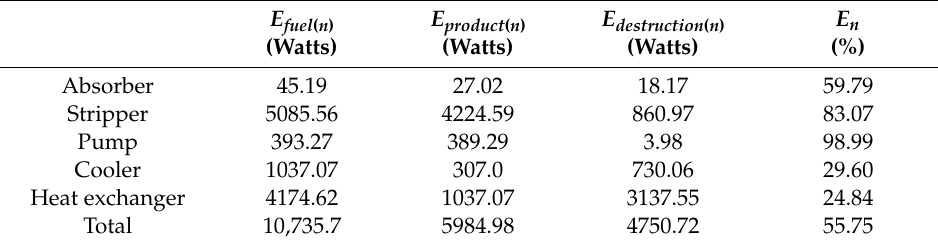
Table 2. Conventional exergy analysis of the AMP-based CO 2 capture